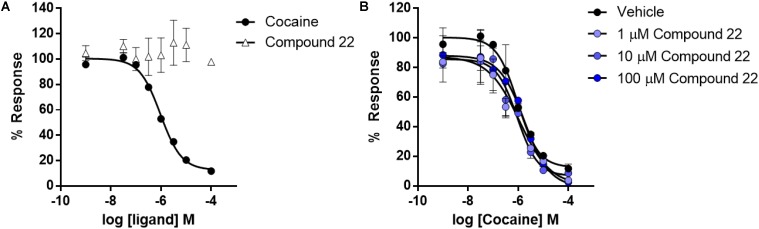
Dose response curves for cocaine and compound 22 effects on dopamine transporter uptake activity. Dose response curves were generated for compound 22 or cocaine by the addition of a range of doses to HEK293 cells stably expressing human HA-DAT. (A) Dose response of cocaine and compound 22 on inhibition of uptake; (B) cocaine co-treatment with: vehicle, 1, 10, or 100 μM of compound 22. Error bars represent standard error of mean at N = 3.